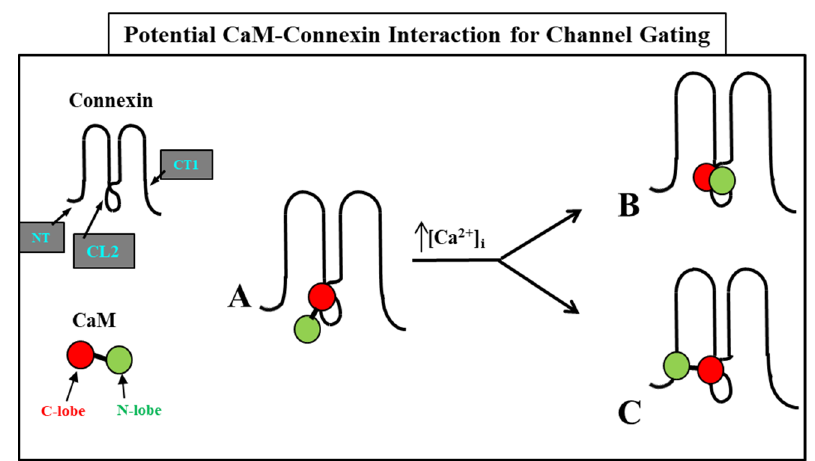
Figure 10. We believe that CaM is anchored to CL2 by its C-lobe lobe ( A ). [Ca 2+ ] i > ~50 nM are believed to cause the N-lobe to gate the channel by interacting hydrophobically and electrostatically with CL2 ( B ) or NT ( C ) domains of the same connexin or another connexin of the same connexon (trans-domain or trans-subunit interaction, respectively), resulting in pore blockage (cork gating model).